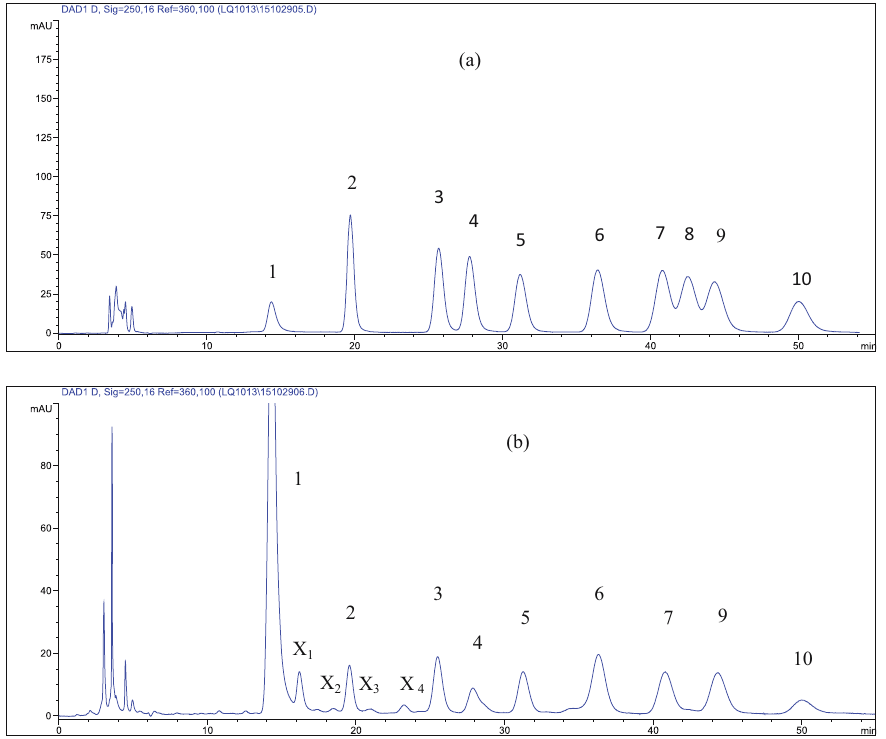
Figure 3: HPLC spectra of mixed standard monosaccharide derivatives ( a ) and hydrolyzed monosaccharide derivatives of RPS ( b ) ( 1. PMP reagent; 2. Man; 3. Rha; 4. GlcUA; 5. GalUA; 6. Glc; 7. Gal; 8. Xyl; 9. Ara; 10. Fuc; X = Unknown ) .